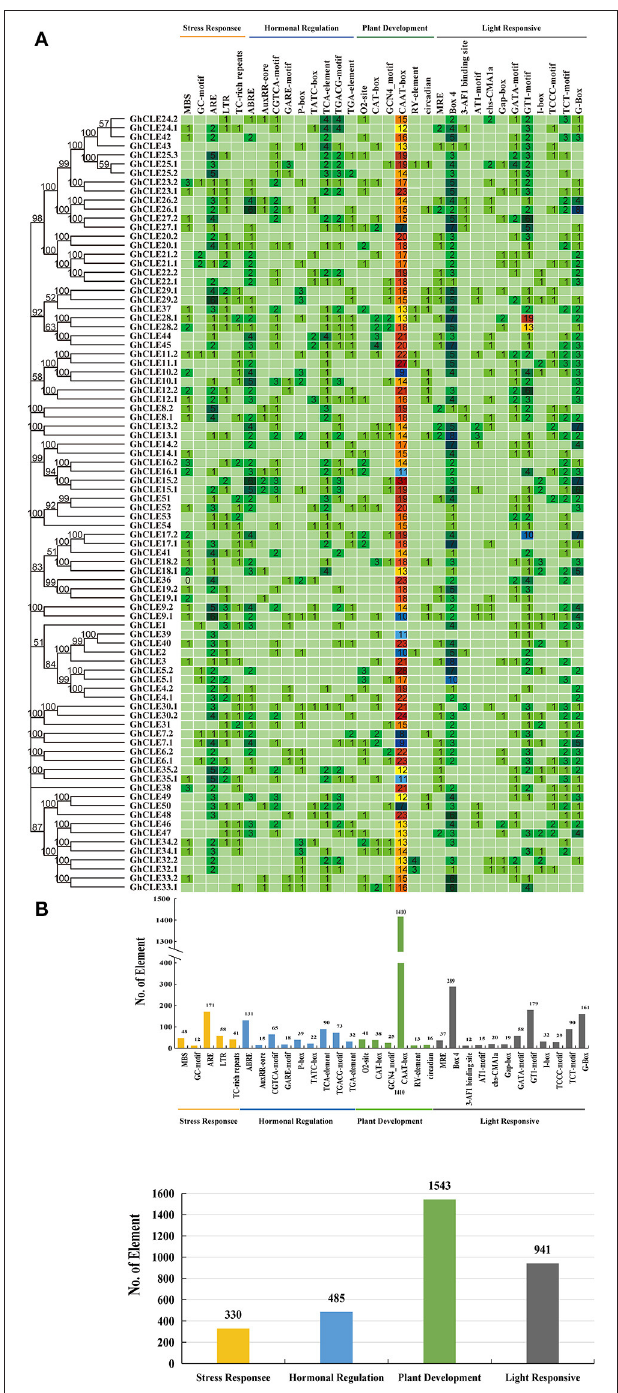
FIGURE 4 | Analysis of C is-acting element numbers in G. hirsutum CLE peptide signals. (A) The colors of the grid indicate the number of C is-acting elements of the GhCLE genes. (B) The bar chart represents the sum of each type of C is-acting elements.